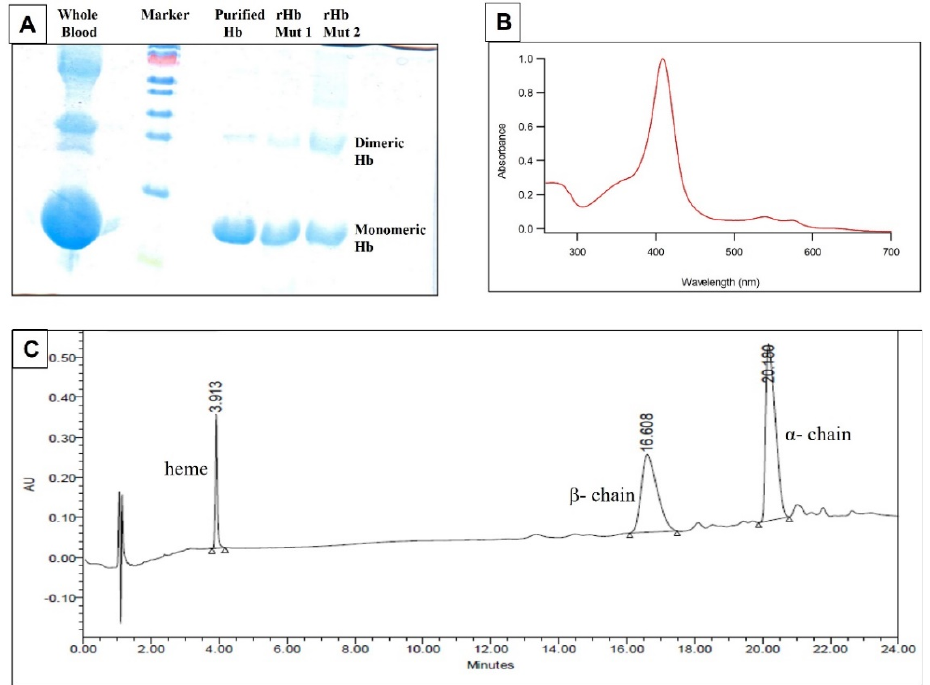
Figure 1. ( A ) SDS − PAGE: lane 1, whole blood; lane 2, marker; lane 3, purified hemoglobin (pure Hb) (isolated from hemoglobind matrix); lane 4, recombinant mutant 1; lane 5, recombinant mutant 2. ( B ) Representative absorbance spectrum of pure Hb. ( C ) Representative UPLC spectrum of pure Hb.